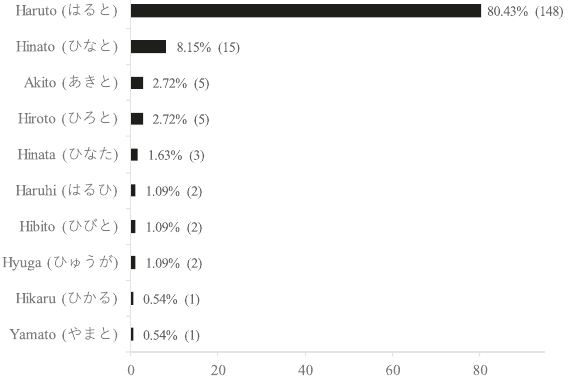
Fig. 2 Variations in readings of the name 陽 翔 . Scores indicate relative frequencies of each reading among the sample ( n = 184). Scores in parentheses indicate the absolute frequencies of each reading.